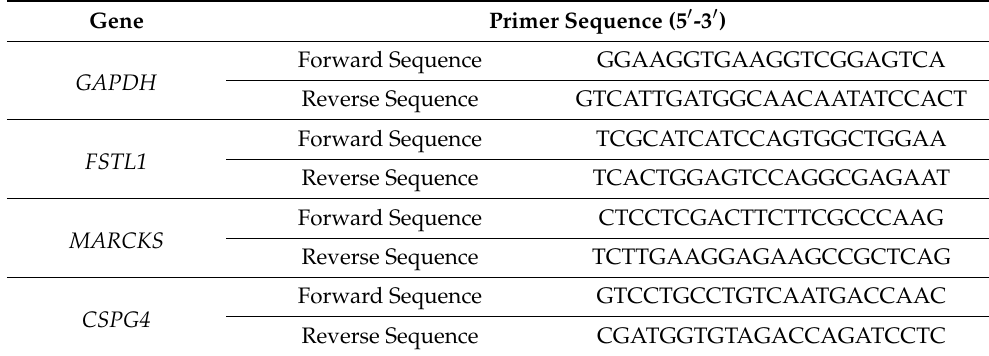
Table 1. The primer sequence for RT-PCR. Gene Primer Sequence (5 (cid:48) -3 (cid:48) )